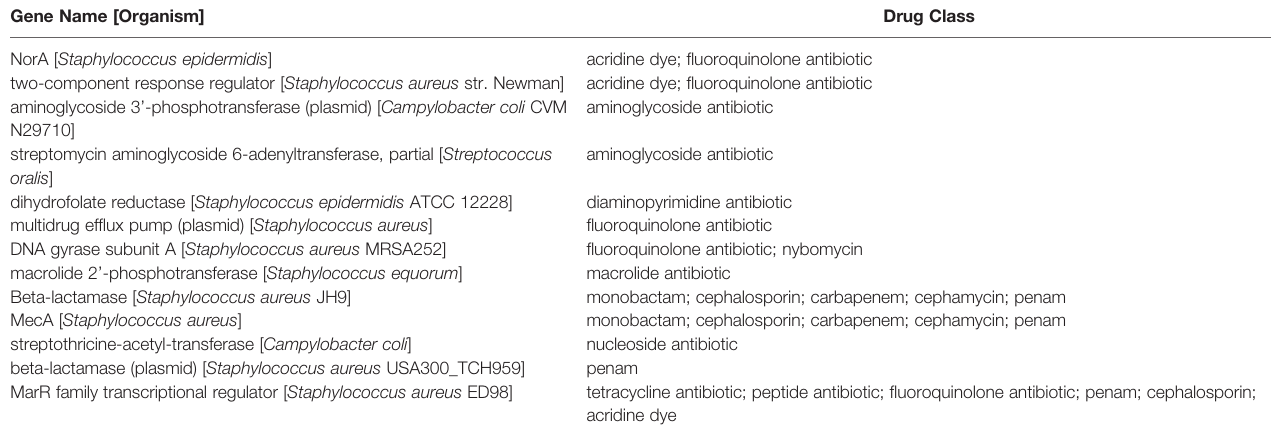
TABLE 2 | Predicted antibiotic resistance genes in the S. epidermidis CLIMB1 genome ascertained from